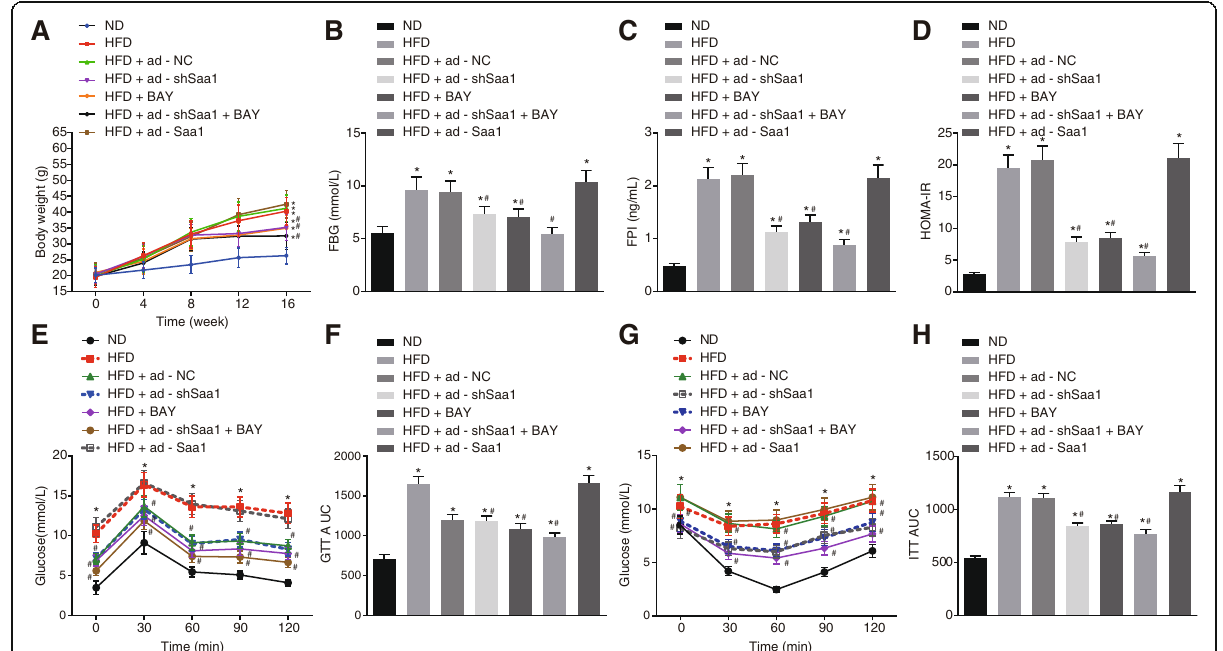
Fig. 4 Glucose tolerance and insulin sensitivity in HFD mice are inhibited by silencing of Saa1. a , body weight changes of HFD mice in response to the treatment of HFD + ad-shSaa1, HFD + BAY, HFD + ad-shSaa1 + BAY and HFD + ad-Saa1 at the 0th, 4th, 8th, 12th and 16th week; b , the FBG of HFD mice after 12-h fasting in response to the treatment of HFD + ad-shSaa1, HFD + BAY, HFD + ad-shSaa1 + BAY and HFD + ad-Saa1; c , the FPI of HFD mice after 12-h fasting in response to the treatment of HFD+ad-shSaa1, HFD+BAY, HFD+ad-shSaa1+BAY and HFD+ad-Saa1; d , HOMA-insulin resistance of HFD mice in response to the treatment of HFD+ad-shSaa1, HFD+BAY, HFD+ad-shSAA1+BAY and HFD+ad-SAA1; e , the blood glucose levels of HFD mice in response to the treatment of HFD+ad-shSaa1, HFD+BAY, HFD+ad-shSaa1+BAY and HFD+ad-Saa1 according to GTT; f , AUC of HFD mice in response to the treatment of HFD+ad-shSaa1, HFD+BAY, HFD+ad-shSaa1+BAY and HFD+ad-SAA1; g , blood glucose levels of HFD mice in response to the treatment of HFD+ad-shSaa1, HFD+BAY, HFD+ad-shSaa1+BAY and HFD+ad-Saa1 corresponding to insulin resistance test; h , AUC of HFD mice in response to the treatment of HFD+ad-shSaa1, HFD+BAY, HFD+ad-shSaa1+BAY and HFD+ad-Saa1 corresponding to insulin resistance test; data were expressed by means ± standard deviation; multiple groups were compared by one-way analysis of variance; n =15; *, p <0.05 vs. the ND group; #, p < 0.05 vs. the HFD group. Saa1, serum amyloid A protein 1; ND, normal diet; HFD, high-fat diet; GTT, glucose tolerance test; AUC, area under the curve; NC, negative control; FPI, fasting plasma insulin; FBG, fasting blood glucose; HOMA-insulin